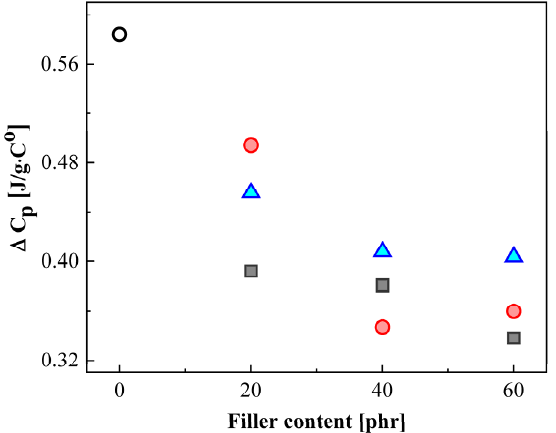
for NBR-H40 and 60. Similar to Figure 8, since the contribution of DC conductivity to the